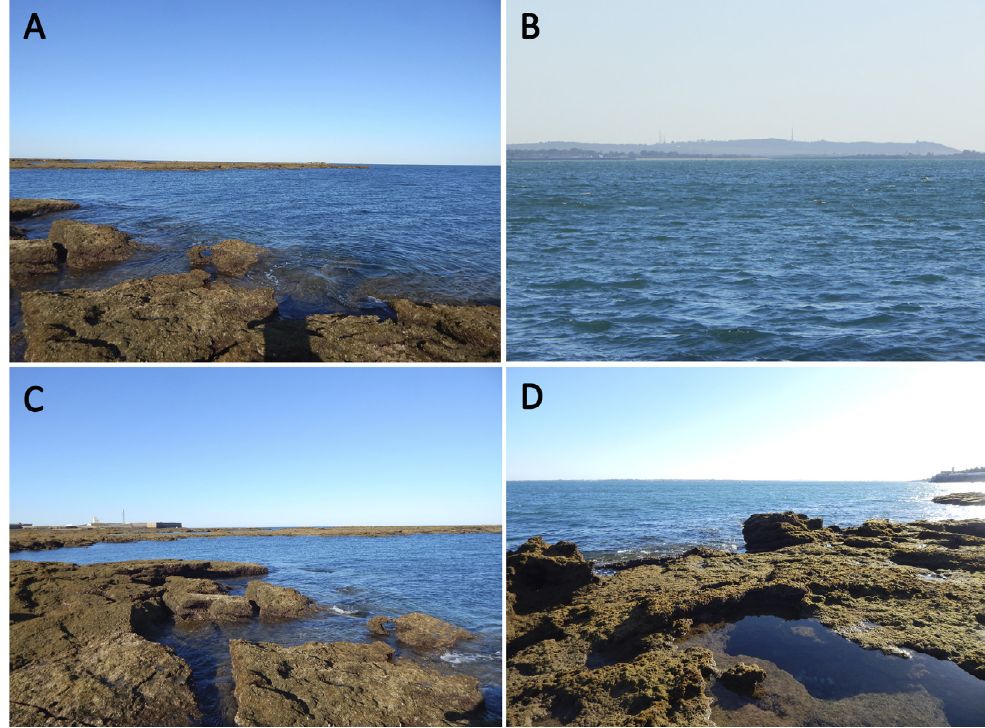
Figure 15. Range of visibility from the Punta del Nao-point 1 . A. Towards the tip of the Punta del Nao. B. Towards the interior of the Bay where, in the distance, the Sierra de San Cristobal can be observed. The necropolis of Las Cumbres and the Castillo de Doña Blanca settlement are situated at the foot of this sierra. C. Towards San Sebastian Castle. D. Towards the interior of the Bay and part of the modern city of Cadiz.